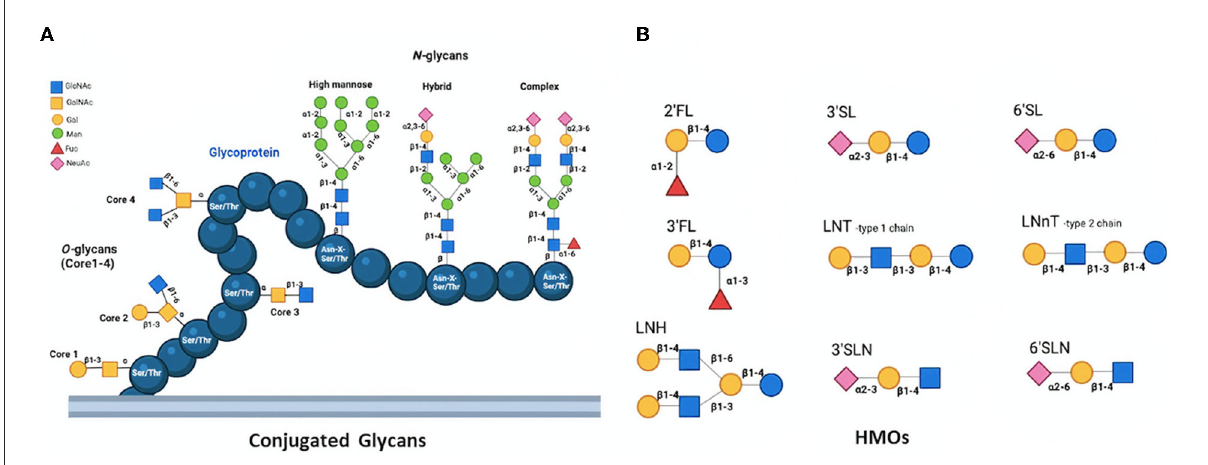
FIGURE1 Structures of O- glycans (Core 1-4) and N- glycans (high mannose, hybrid, and complex) conjugated a glycoprotein (A) and Basic HMOs (B) (18, 19).